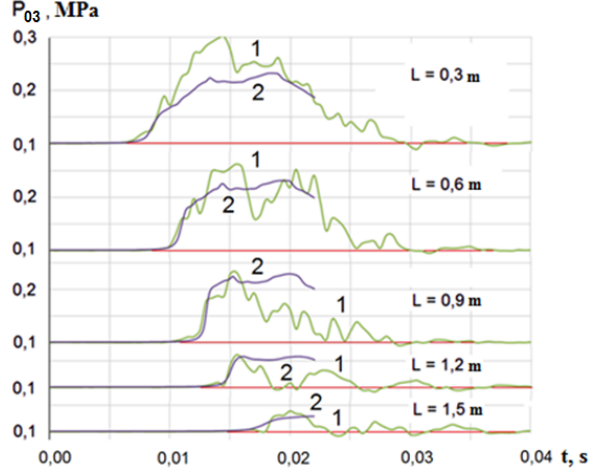
Figure 7. Pressure measurement on the impulse jet axis for P 0 (0) = 0.70 MPa: 1—experimental results; 2—results of non-stationary calculation.